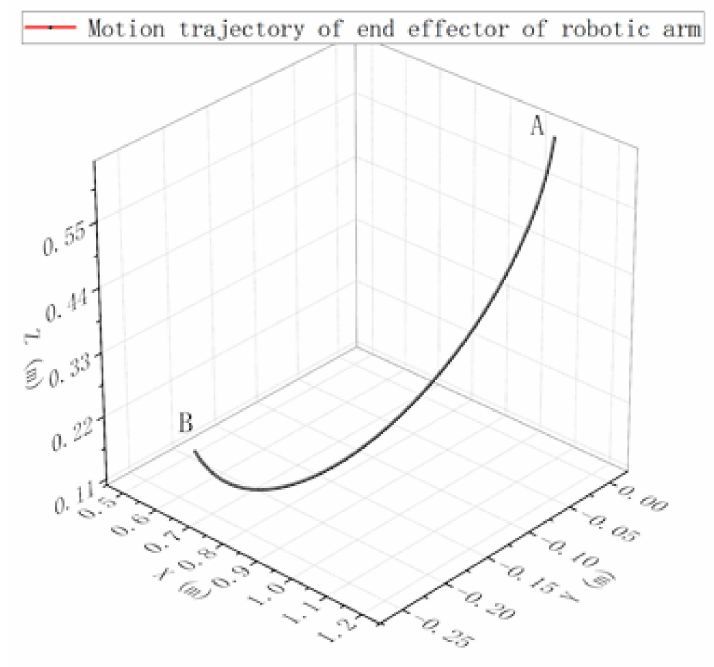
Figure 20. The actual trajectory of the